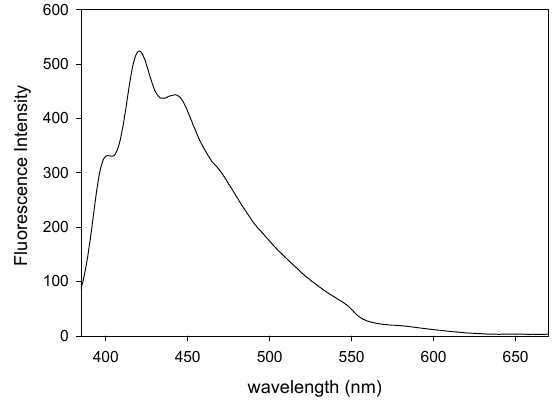
Figure 3. Fluorescence spectrum of the BIEE/pDMAEMA/pAnMMA semi-IPN polymer network pre-swollen in methanol. Excitation wavelength: 370 nm.